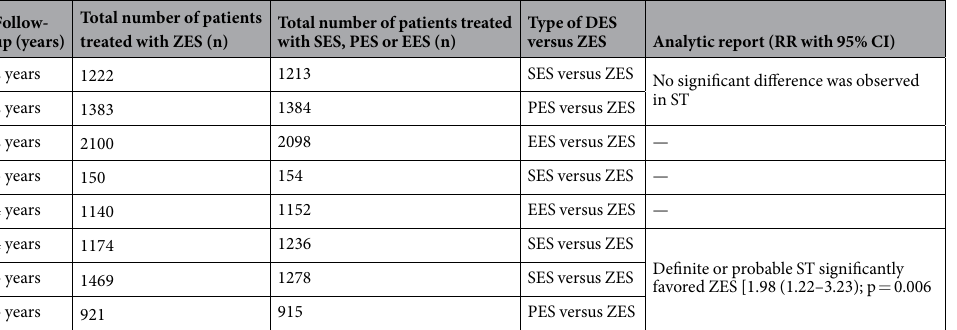
Total number of patients treated with SES, PES or EES (n)